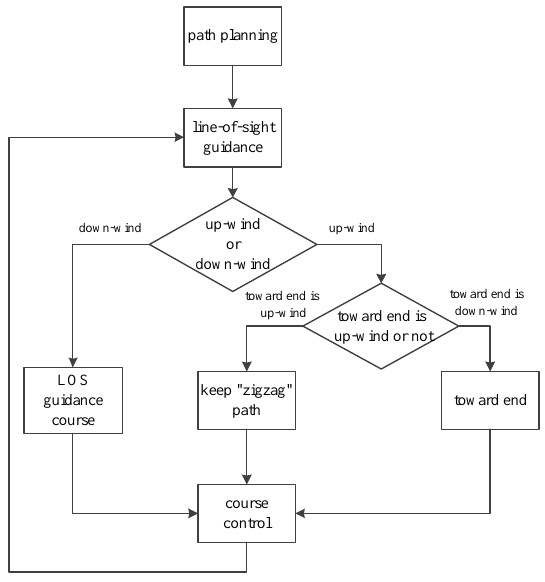
Figure 6. Guidance strategy flow